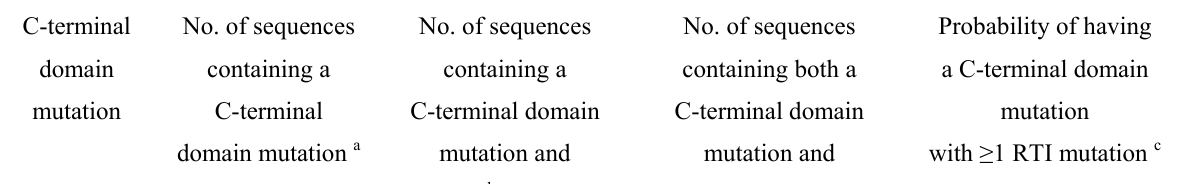
Table 1. Prevalence of C-terminal Domain Mutations in RTI Treatment-experienced